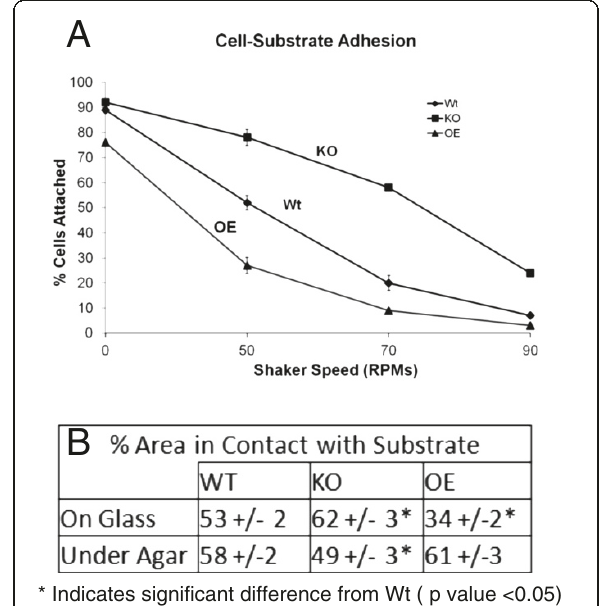
Figure 4 AmpA influences cell substrate adhesion and substrate contact area. A ) AmpA influences cell substrate adhesion. Cells grown on petri dishes were shaken at increasing shaker speeds, RPM (rotations per minute) for 45 minutes and the percent of cells remaining on the dish was determined. B ) AmpA influences the % of the cell surface in contact with the substrate. To determine the percentage of the cell in contact with the substrate cells were imaged using transmitted light and in reflection mode to identify the area of the cell in contact with the substrate (Additional file 7 for raw data). The area of the cell and the area of the contact sites were determined and the contact sites were expressed as a % of the total area of the cell. The number of cells imaged was 65 to 125 for cells sitting on glass and 50 to 95 for cells migrating under agar. Results are averages from two different experiments preformed on different days. Error bars are the standard error of the mean. * indicates a significant difference with a P value < 0.05 using a two tailed paired Student ’ s